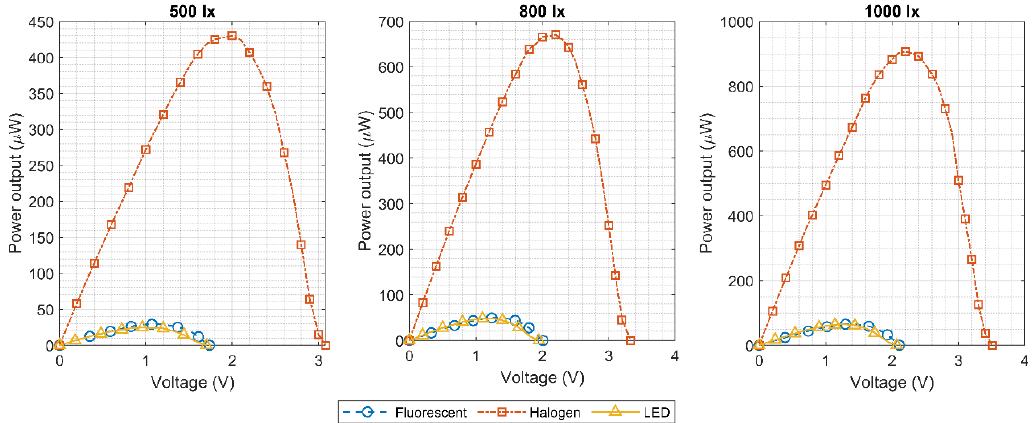
Figure 11. Measured output power of three KXOB25-05X3F solar cells in series.